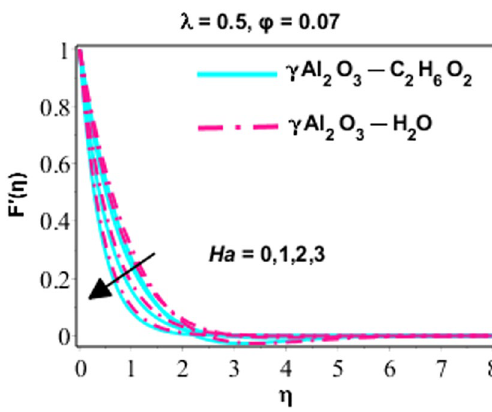
Figure 4. Character of F ′ (η) as varying Ha .